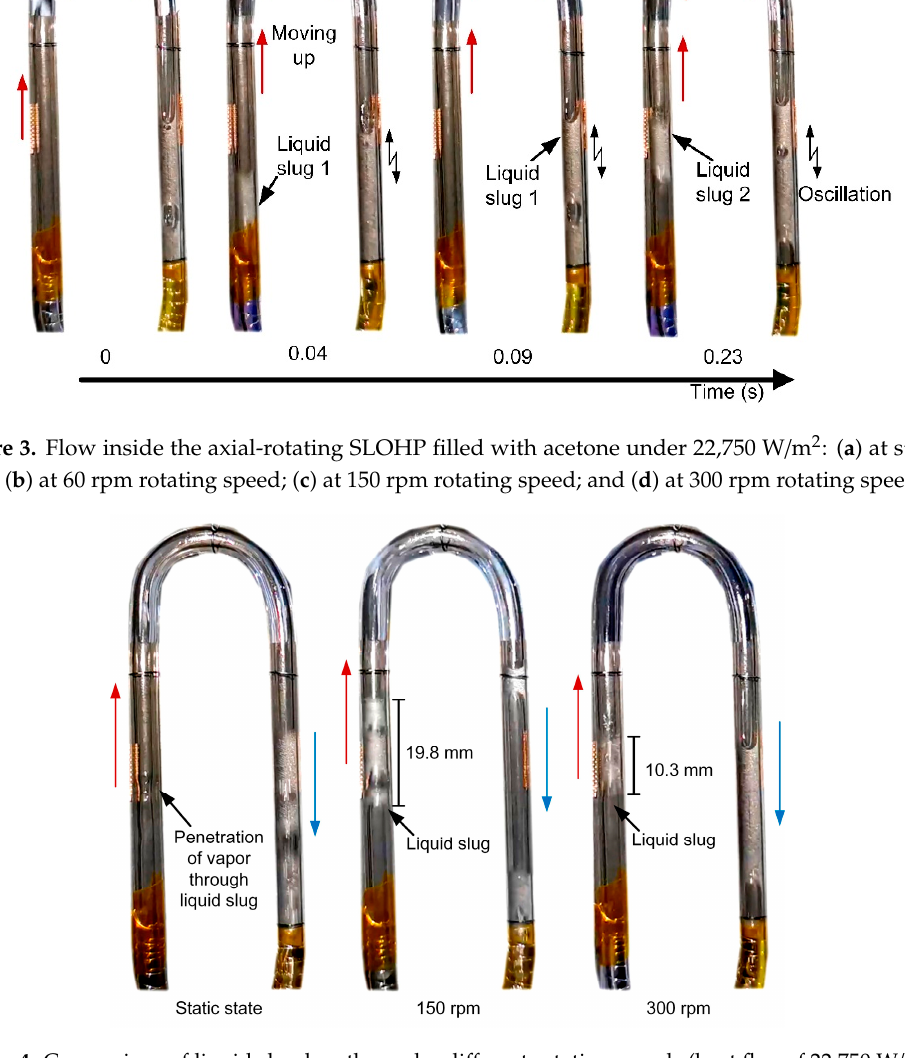
Figure 4. Comparison of liquid slug lengths under different rotating speeds (heat flux of 22,750 W/m 2 ).